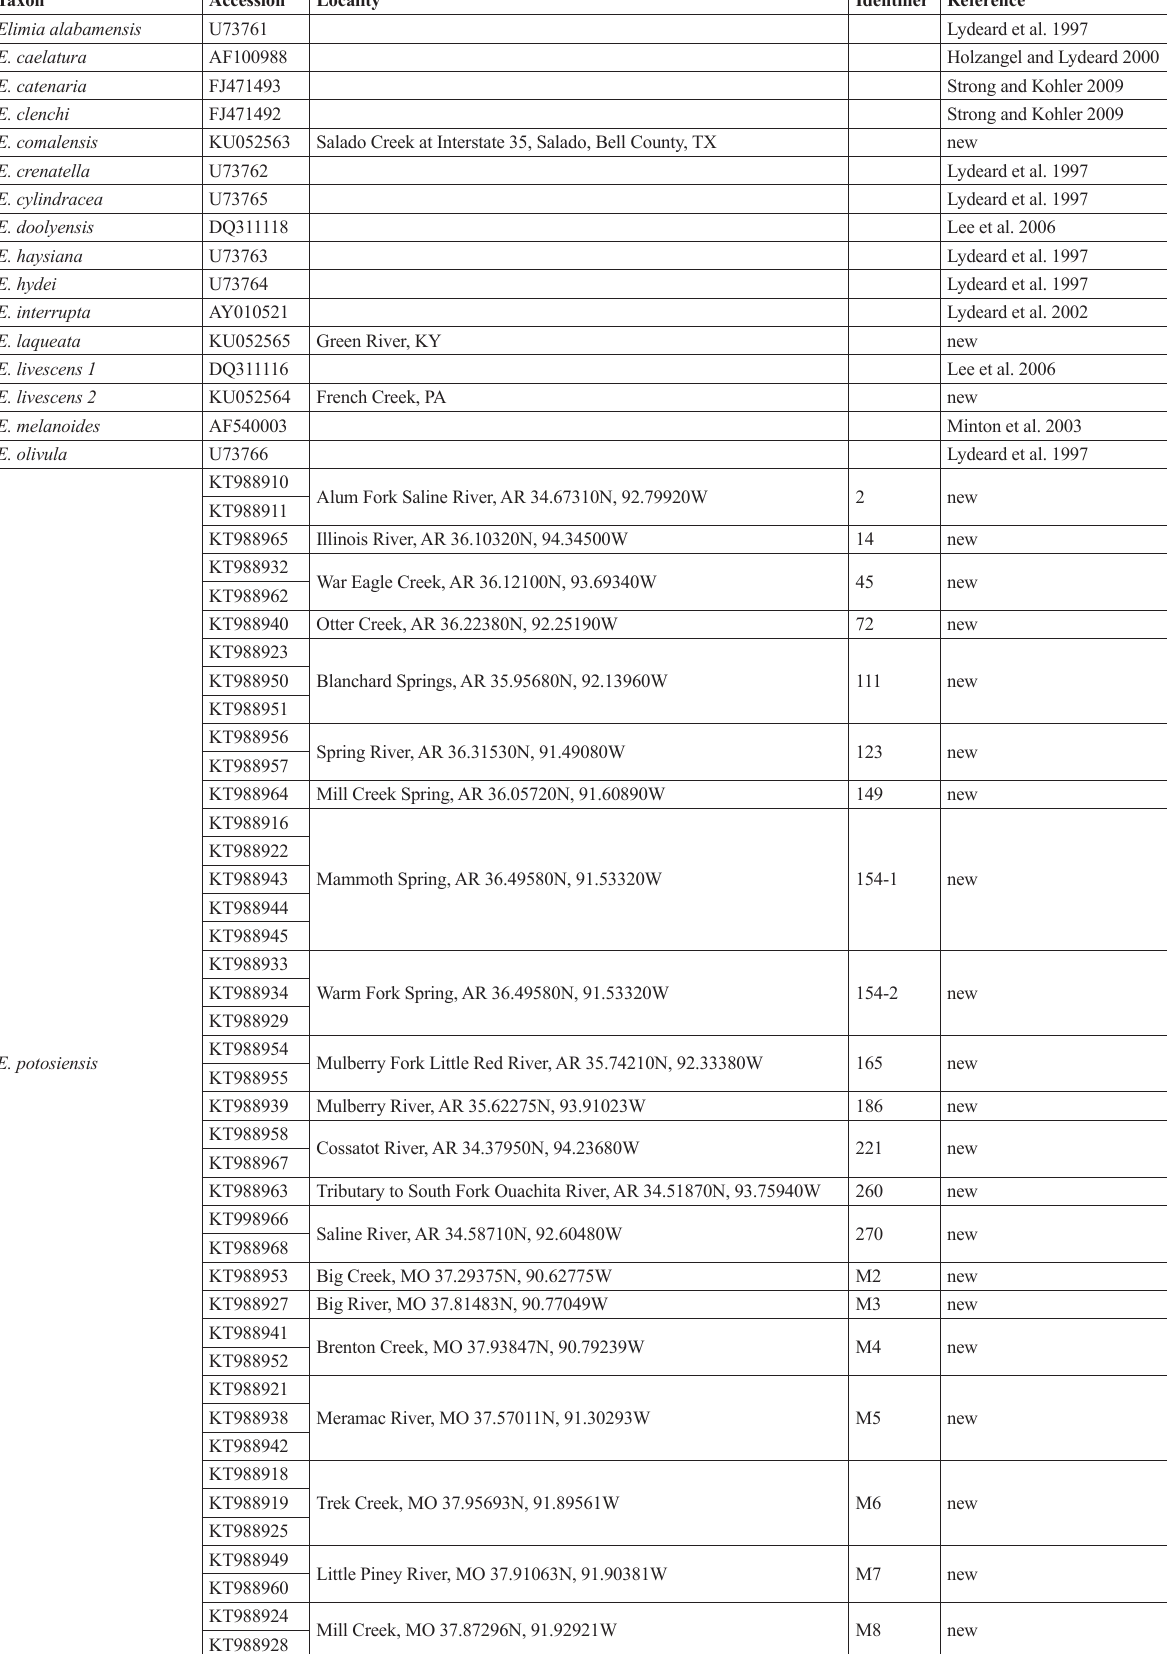
Table 1. Locality and NCBI accession numbers for sequences used in this